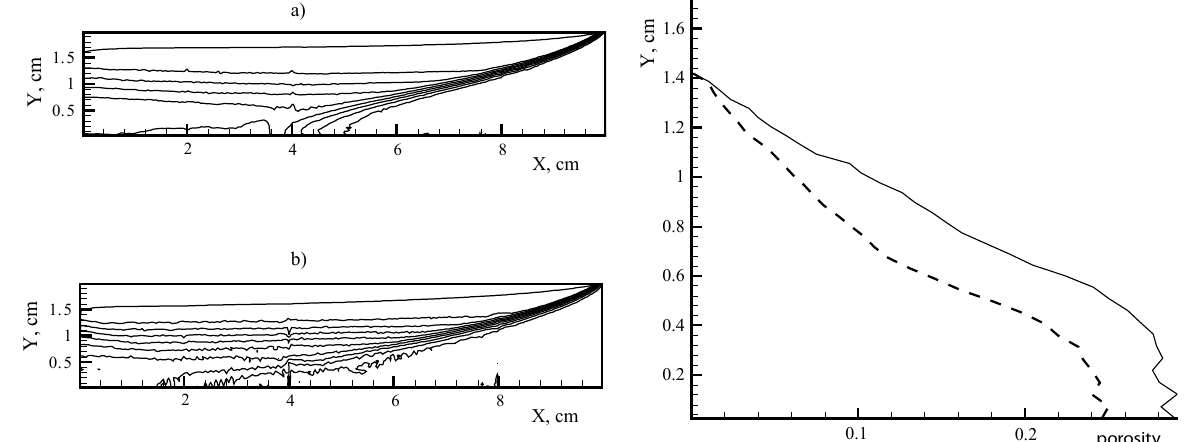
 cm: а ) cylindrical e